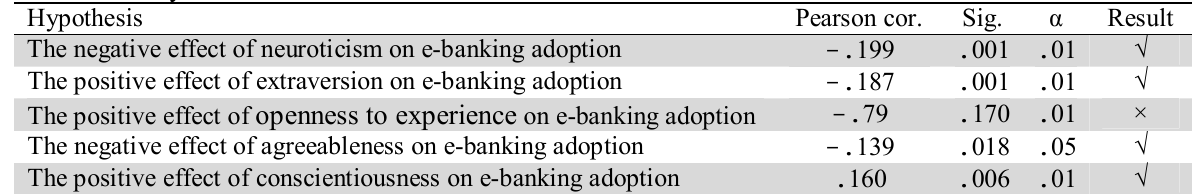
The summary of Pearson correlation ratios Hypothesis Pearson